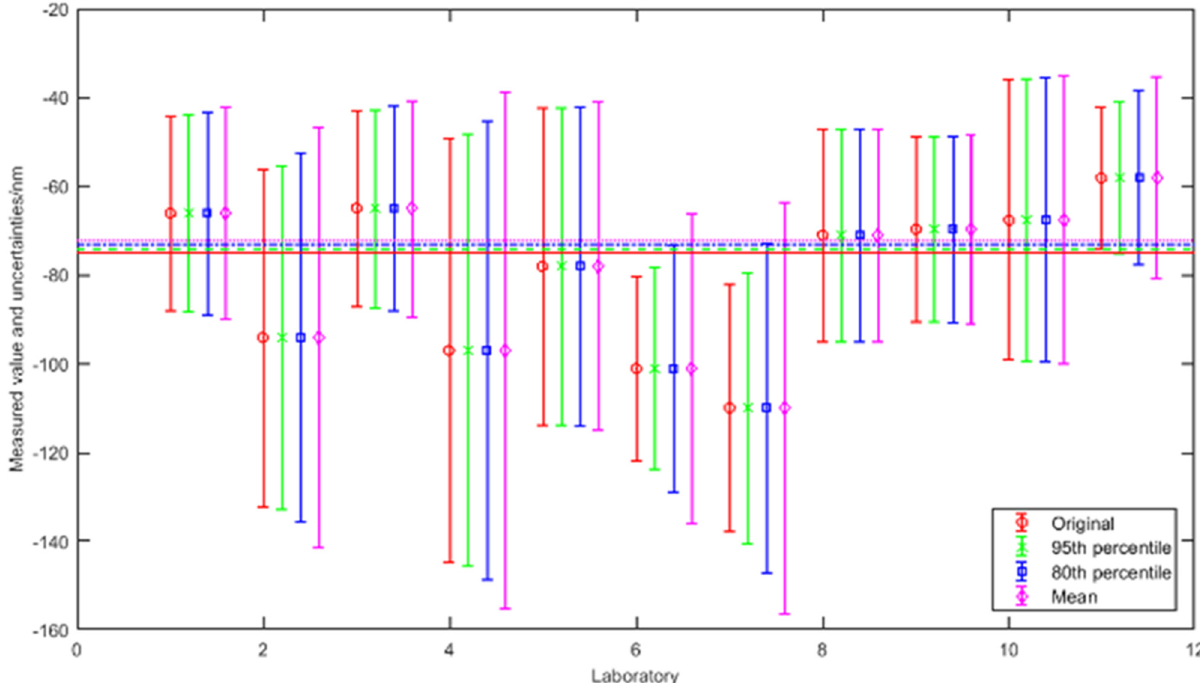
Fig. 1. Estimates and 95% con fi dence intervals of a 100mm gauge block. The graph shows the uncertainty bars x j ±2 u j for the input uncertainties u 0 , the fi rst set of uncertainty bars in each group, and for the adjusted uncertainties based on the relative entropy method u at the 95th percentile, second set, 80th percentile, third set and the mean, fourth set. The horizontal lines are the weighted means determined from the input uncertainties (red solid line), adjusted uncertainties to the 95th percentile (green dashed line), adjusted uncertainties to the 80th percentile (blue dotted and dashed line) and adjusted uncertainties to the mean (magenta dotted